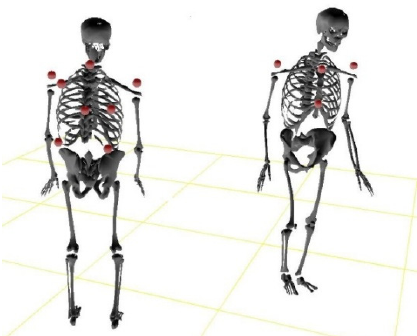
Figure 6. Markers of interests—possible positions under investigation for wearable ‐ sensors: ( left ): back view of the possible positions; ( right ): the front view of the possible positions.